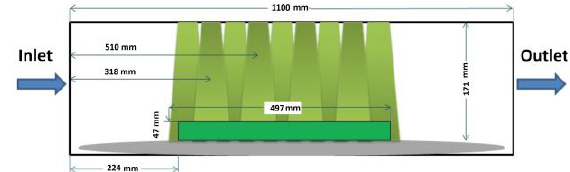
Fig.4 . Scheme of illumination by sectors for obtaining the general velocity field. Distance of 318 and 520 mm indicated vertical sections where velocity profiles were calculated.